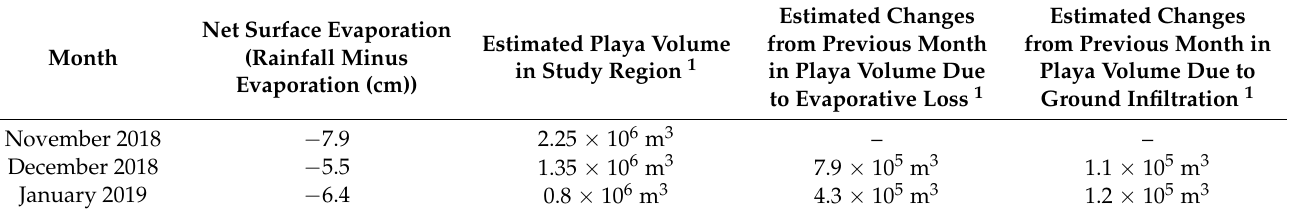
Table 1. Approximation of total surface evaporation and playa volume in the study region between November 2018–January 2019. See text for description of assumptions